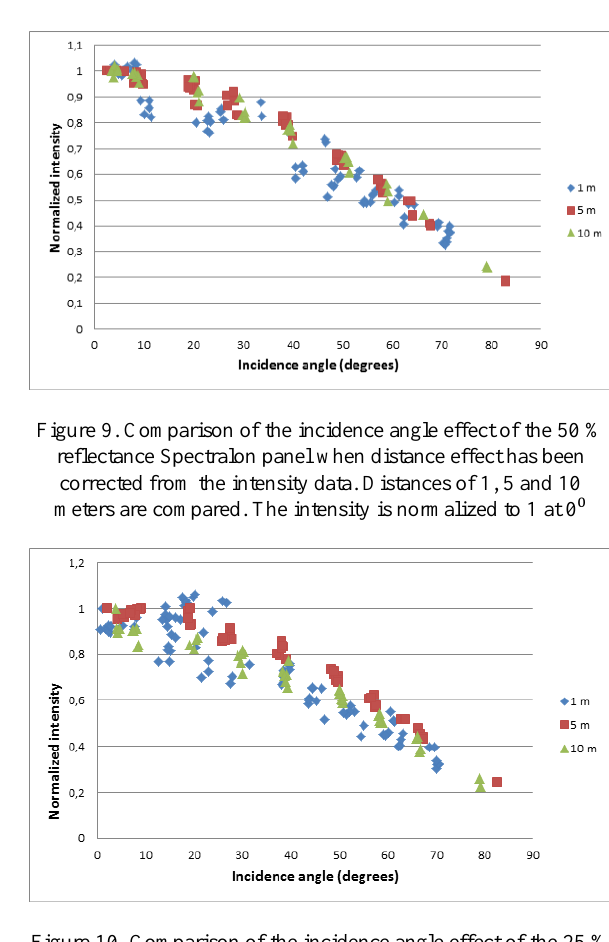
Figure 10. Comparison of the incidence angle effect of the 25 % reflectance Spectralon panel when distance effect has been corrected from the intensity data. Distances of 1, 5 and 10 meters are compared. The intensity is normalized to 1 at 0 ⁰